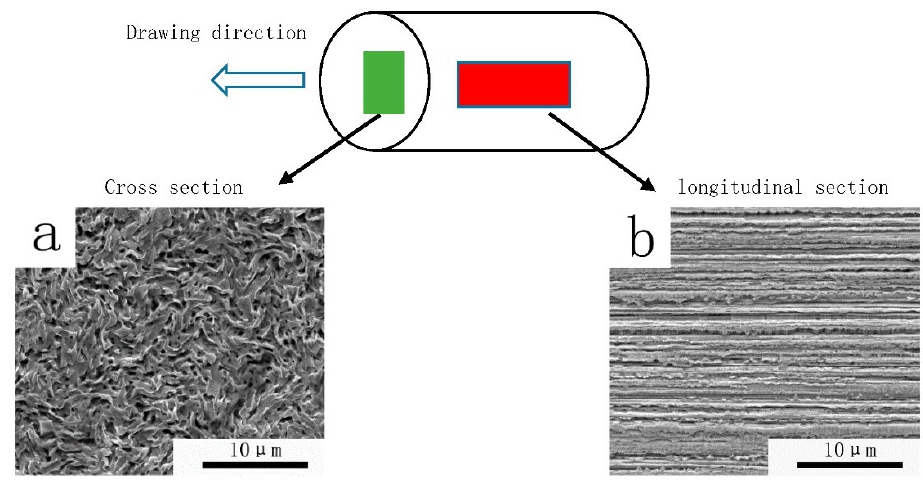
Figure 3. Scanning electron micrographs. ( a ) Cross section microstructure of wire. ( b ) Longitudinal section microstructure of wire.